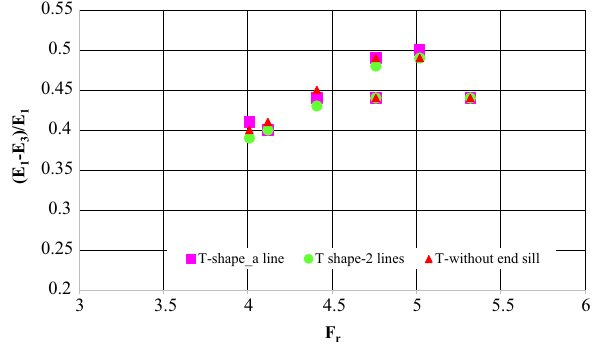
Fig. 16 Comparison of energy-dissipating ratios of the T-shape energy dissipaters depending on layouts